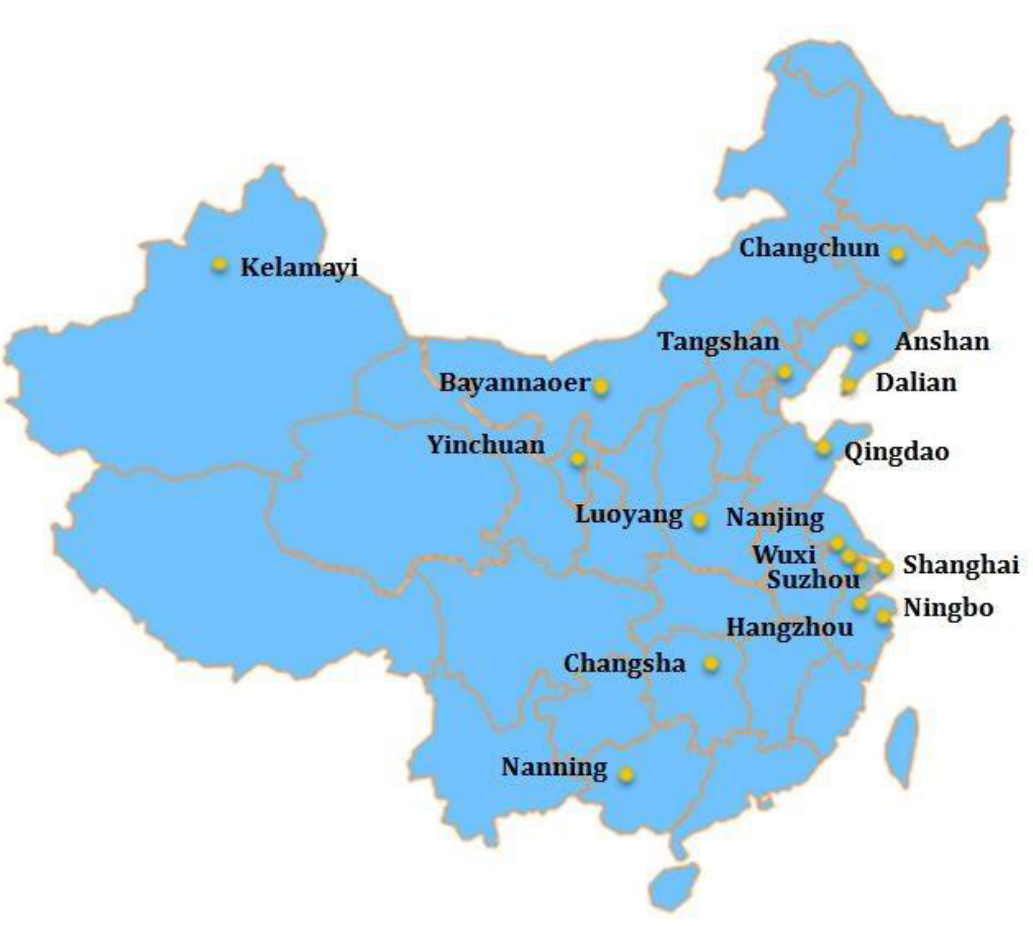
Figure 1. Emory GHI—Tobacco Free